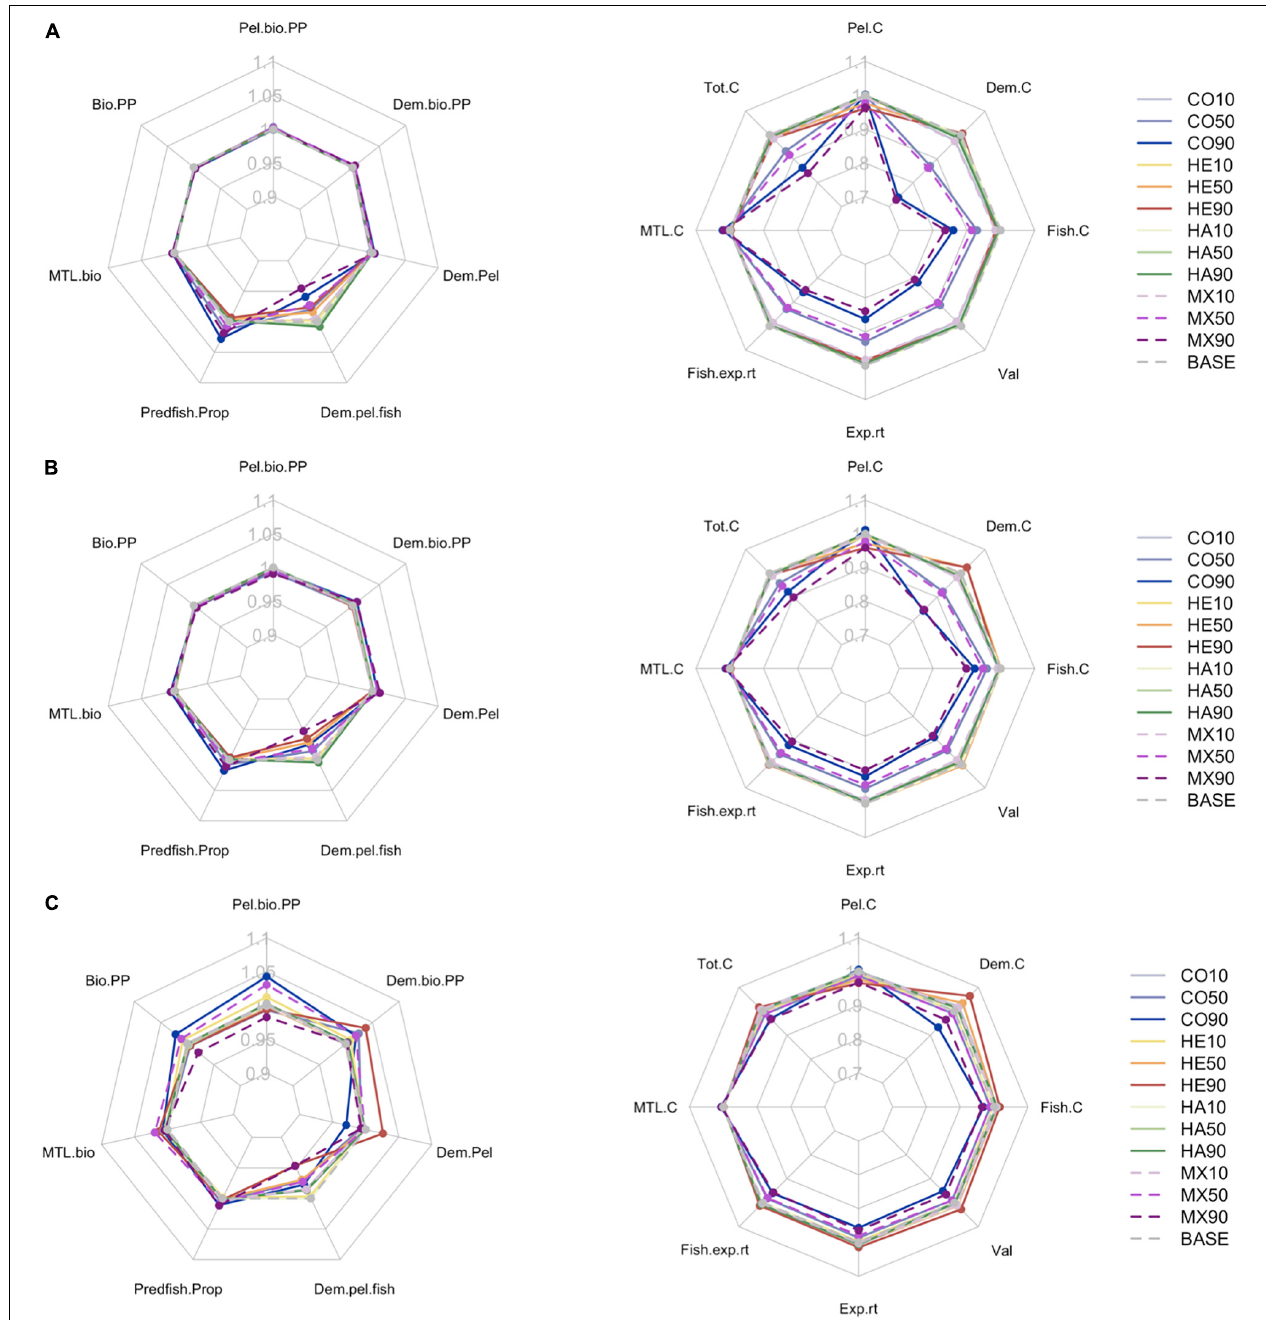
FIGURE 5 | Averages of the ecological (left) and fisheries (right) indicators within the years following a mass mortality event. (A) 5 years post the mortality event, (B) 10 years post the mortality event, (C) 20 years post the mortality event. Displayed values are relative to the baseline run and are based on interannual snapshots of the indicator values. Pel.bio.PP: Pelagic biomass as ratio of primary production, Dem.bio.PP: Demersal biomass as ratio of primary production, Dem.Pel: Demersal – Pelagic biomass ratio, Dem.pel.fish: Demersal – Pelagic fish biomass ratio, Predfish.Prop: Proportion of predatory fish, MTL.bio: mean trophic level of biomass, Bio.pp: total biomass as ratio of primary production, Pel.C: catch of pelagics, Dem.C: catch of demersals, Fish.C: catch of fish, Val: value of catch, Exp.rt: exploitation rate of all, Fish.exp.rt: exploitation rate of fish, MTL.C: mean trophic level of catch, Tot.C: total catch (see Supplementary Table S2 for details).